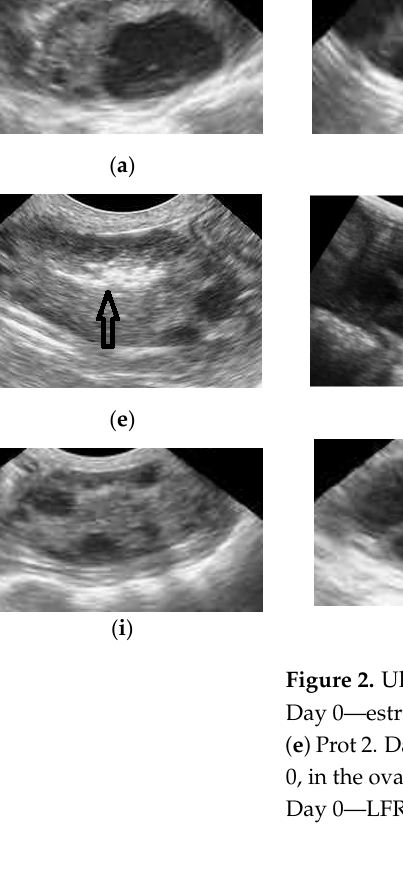
Table 1. Effect of OPU protocol on follicular development, recovery of COCs, and number of blastocysts/OPU session in Holstein cows (Mean ±